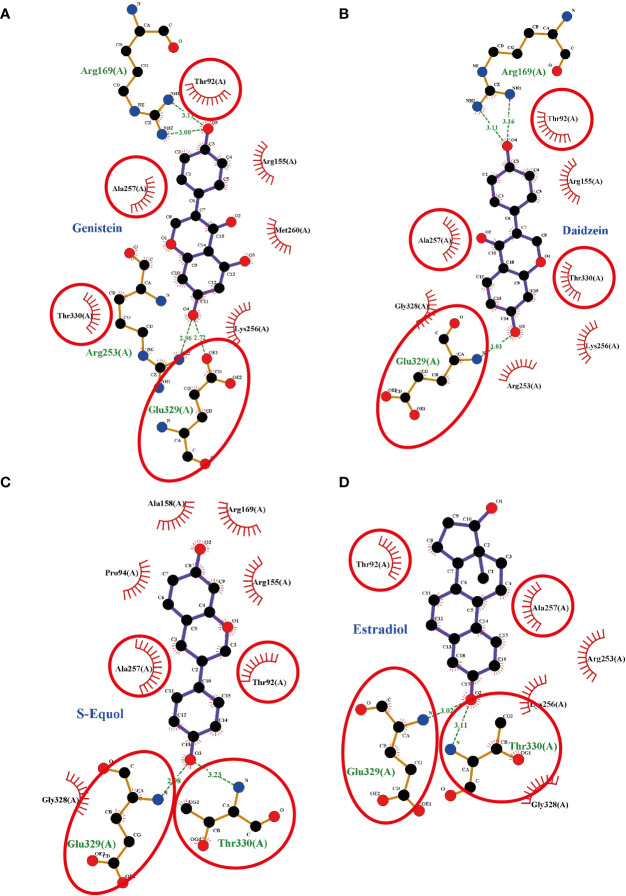
Interaction plots between (A) genistein, (B) daidzein, (C) S-equols, or (D) E2 and the G-protein-coupled estrogen receptor (GPER) generated by LigPlot+ v.2.0, with each subsequent plot being automatically fitted. Red circles and ellipses in each plot indicate amino acid residues that have equivalent 3D positions with respect to the residues in the first plot. Hydrogen bonds are shown as green dotted lines, while spooked arcs represent residues making nonbonded contacts with the ligand.